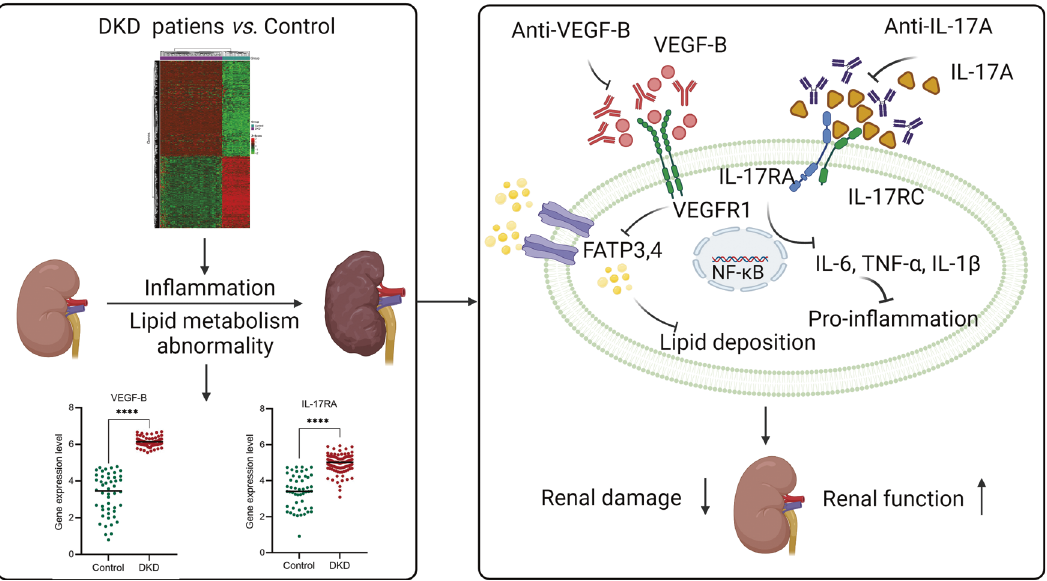
Fig. 7 The graphical abstract of neutralizing of VEGF-B and IL-17A simultaneously to alleviate renal damage and ameliorate renal function. It was demonstrated that the renal lipid metabolism abnormality and in fl ammation signi fi cantly changed in DKD condition by mining public transcriptomic data of DKD patient samples. Further analysis exhibited the critical role of VEGF-B and IL-17A signal pathways in DKD progression, it indicated that VEGF-B and IL-17A might be promising targets for DKD treatment. Then the potential of a novel combination therapy, anti-VEGF-B plus anti-IL-17A antibody, was evaluated for DKD treatment. The results demonstrated that simultaneous blockade of VEGF-B and IL-17A signaling with neutralizing antibodies exhibited a synergistic effect on alleviating renal injury and ameliorating the renal function by reducing lipid deposition, normalizing the content of proin fl ammatory and alleviating the renal fi brosis in the DKD mouse